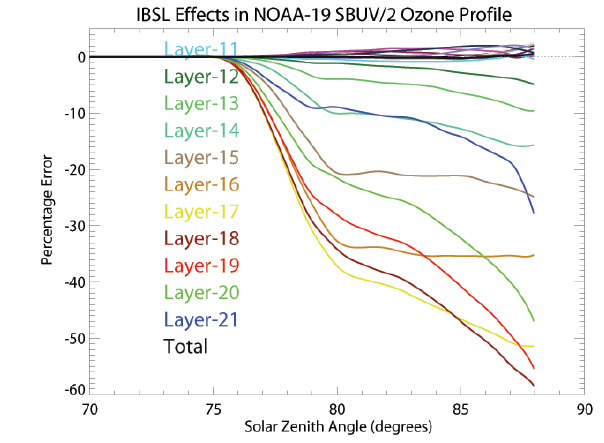
Fig. 15. N19’s dIBSL/dSCSEA at SCSEA = 6 ◦ is calculated with IBSL at SCSEA =− 10 ◦ in the IPAR analysis on the dayside and measurements at SCSEA = 6 ◦ on the nightside.